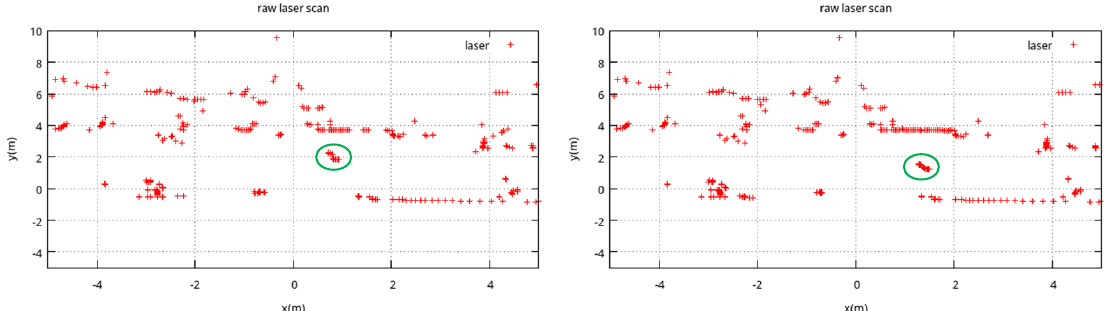
Figure 3. Laser ranging data at two